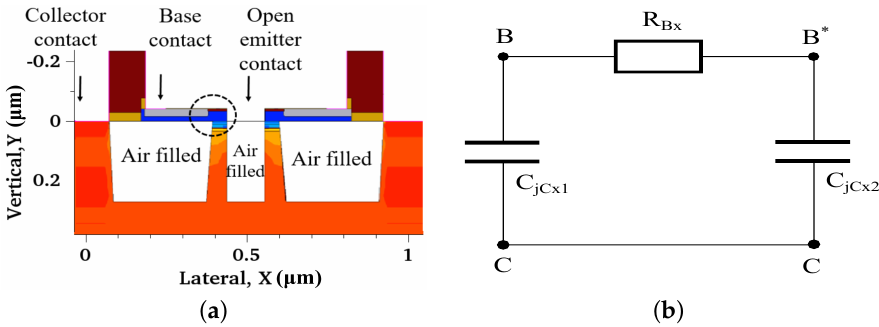
Figure 7. Customized TCAD structure ( a ) and RC equivalent circuit ( b ) representing the left circled region for the determination of cjcx . B is the external base